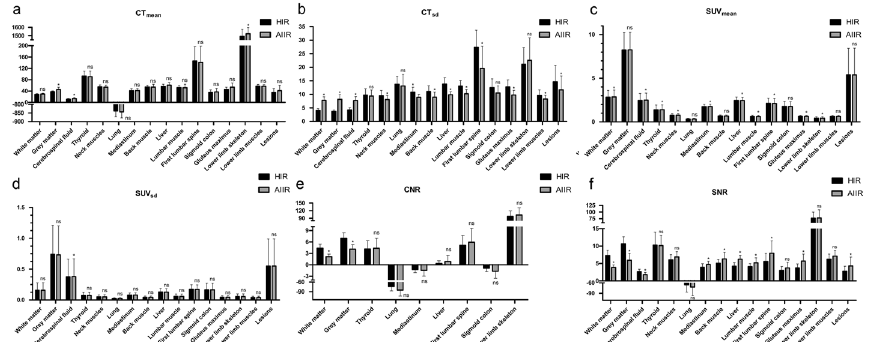
Fig. 4 Box plot of objective parameters of ULDCT-AIIR and SDCT-HIR. (* p < 0.05; ns no significance)